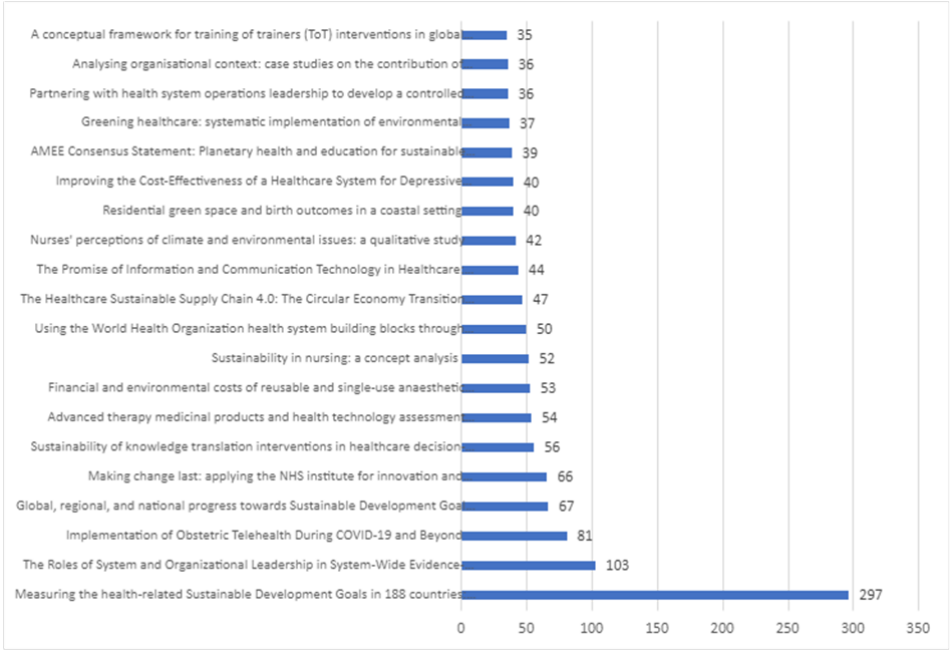
Figure 9. The total number of citations per paper .